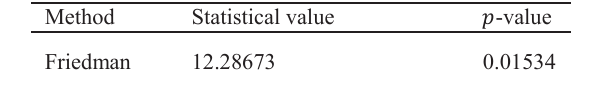
Table 12. Results of Friedman’s test based on the average best-so-far for multimodal test functions of set 1.